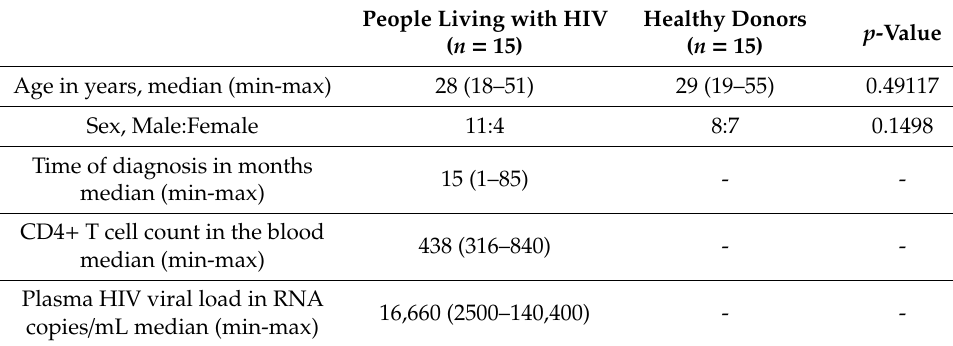
Table 1. Demographic and clinical